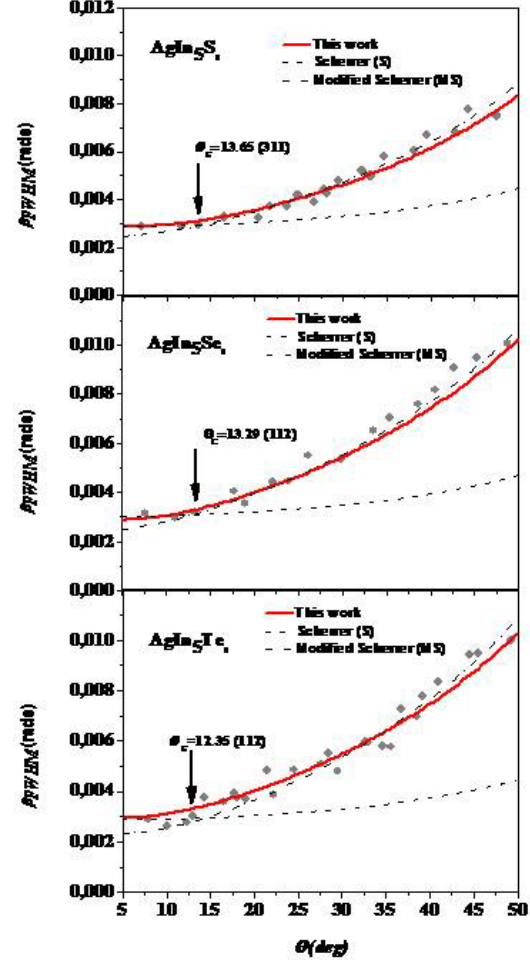
) as function of the Figure 4. Full-Width-Half-Maximum ( β FWHM diffraction angle for each sample. The solid curves are numerical fits of the experimental data using equation (13). The fitting parameters obtained from these fits are listed in Table 1. The dashed-dotted curve is calculated with the modified Scherrer formula (5), and the dashed curve corresponds to the conventional Scherrer formula.